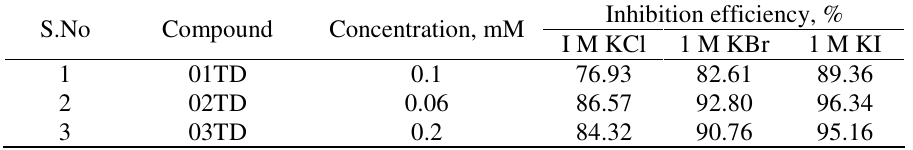
Figure 1. Inhibition efficiency vs. concentration of compounds [(01TD), (02TD) and SO . (03TD) on the surface of mild steel in 1 M H 2 4 Table 2. Corrosion parameters of variously substituted thiadiazolines on mild steel at various halides in 1 M H SO 2